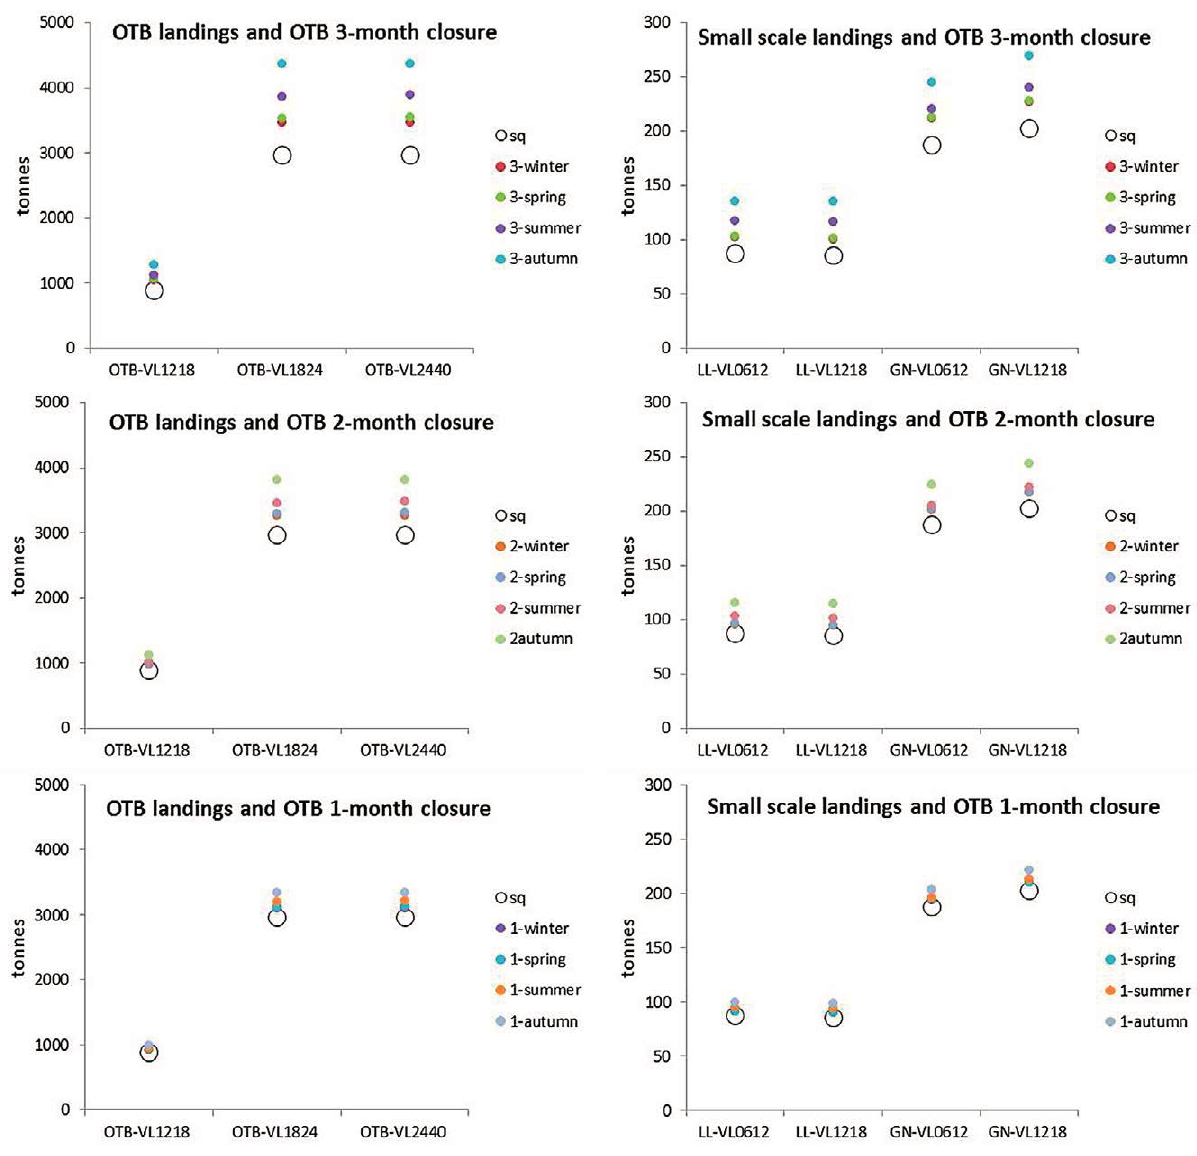
Fig. 4. – Catches by gear and fleet segment (left column, otter bottom trawl; right column, small-scale fishing) after five consecutive years of implementation of otter bottom trawl seasonal closures of three, two and one months. Note that small-scale fishing gears benefit from these